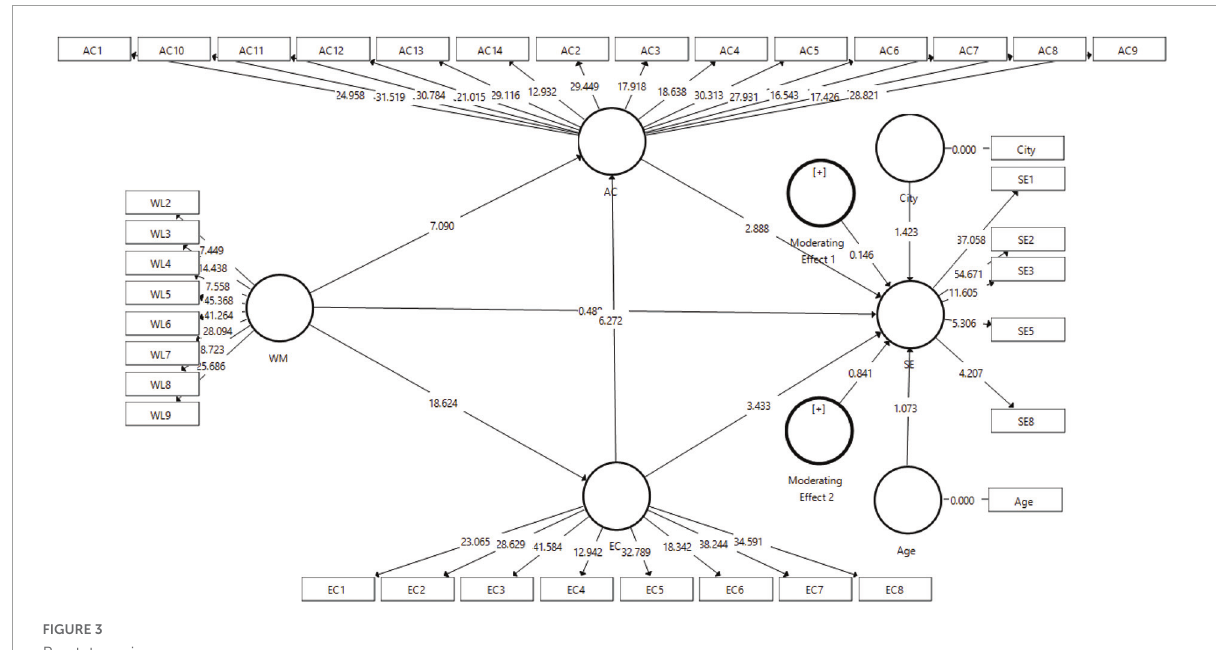
FIGURE3 Bootstrapping.